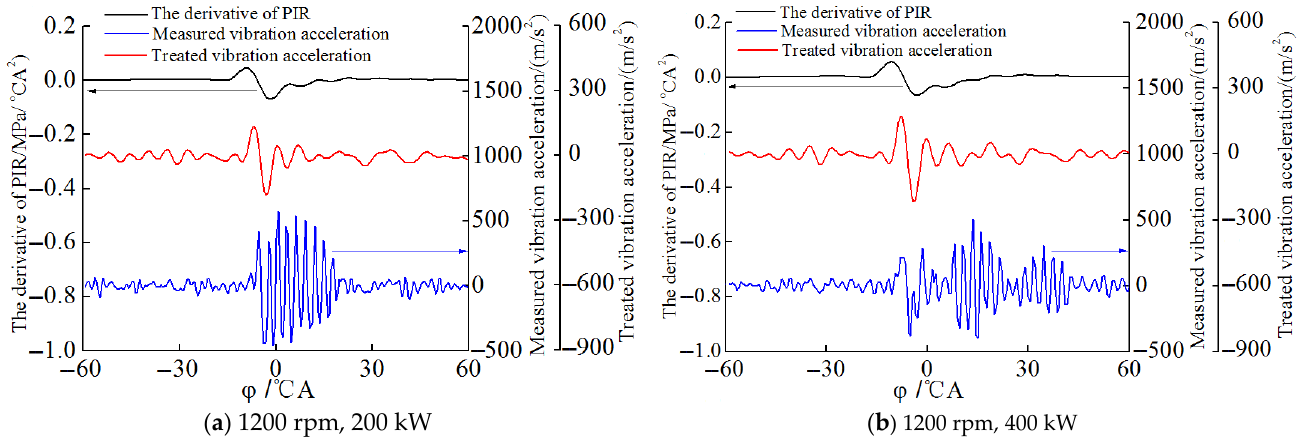
Figure 13. The comparison of the derivative of PIR and the raw and filtered vibration signal.